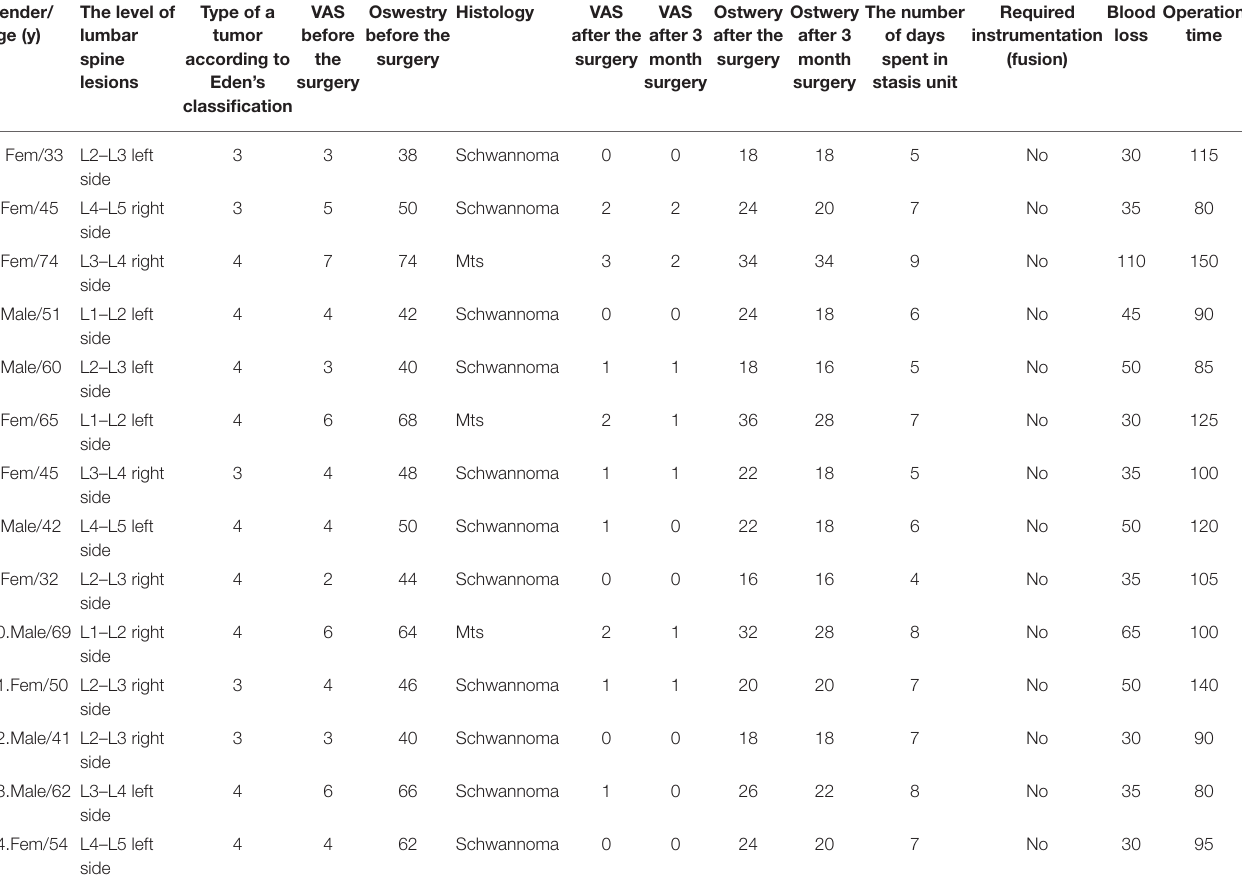
TABLE 1 | Results of performed surgery on 14 patients (Experimental group). Gender/ The level of age (y)